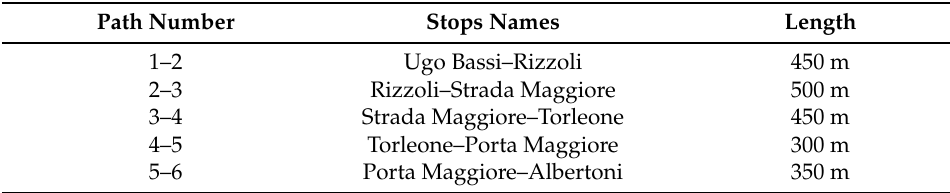
Table 3. Line 15—Outward journey. Names of the trolleybuses’ stops.